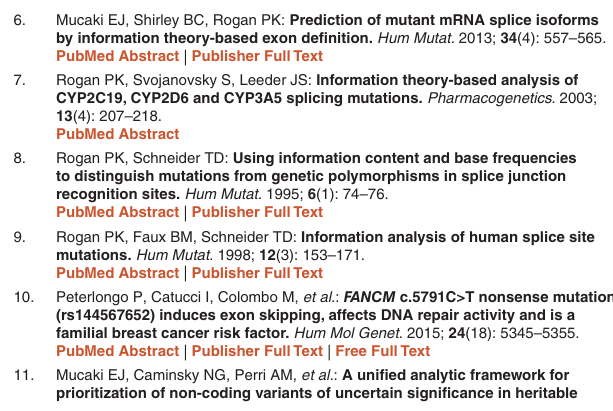
sifications. Supplementary figure containing six histograms (generated with GraphPad Prism v6.0). A variant may occur in mul- tiple individuals, tissue types, or splice sites. Histograms present the fraction of molecular phenotype classifications which are consistent among all cases for variants found in at least 2, 3, 5, 10, 15, and 20 different tissue types. DOI: https://doi.org/10.5281/ Zenodo: Dataset 3. Mutations which lead to multiple types of aberrant splicing. Representative set of mutations which sig- cal (i.e. cryptic splice site use, exon skipping, intron inclusion). Mutations are linked to their page on